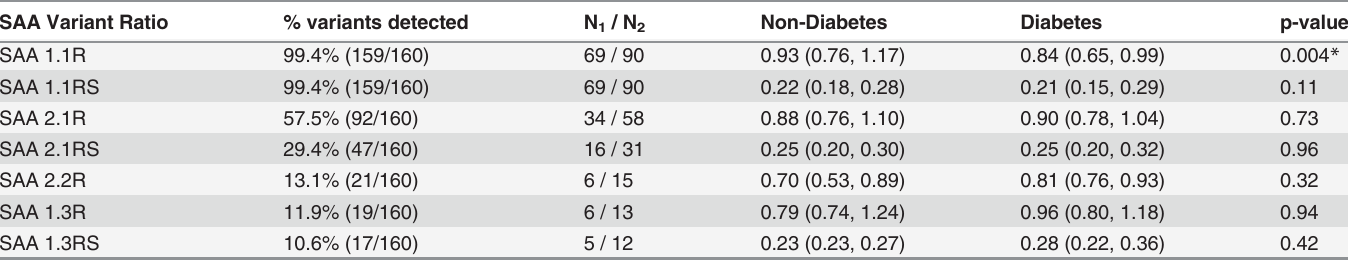
Table 3. Comparison of SAA variant ratios between the diabetes and non-diabetes groups. SAA Variant